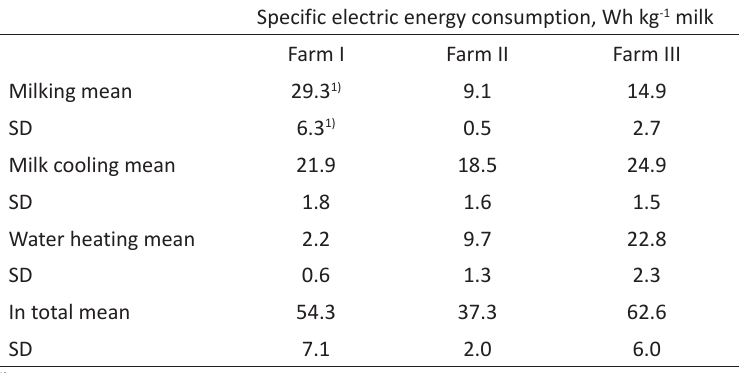
Table 3. Specific energy consumption of the examined tasks on the case farms, including the standard deviation (SD) of the monthly variation. It must be noted that these figures cannot be directly compared due to the differences in the